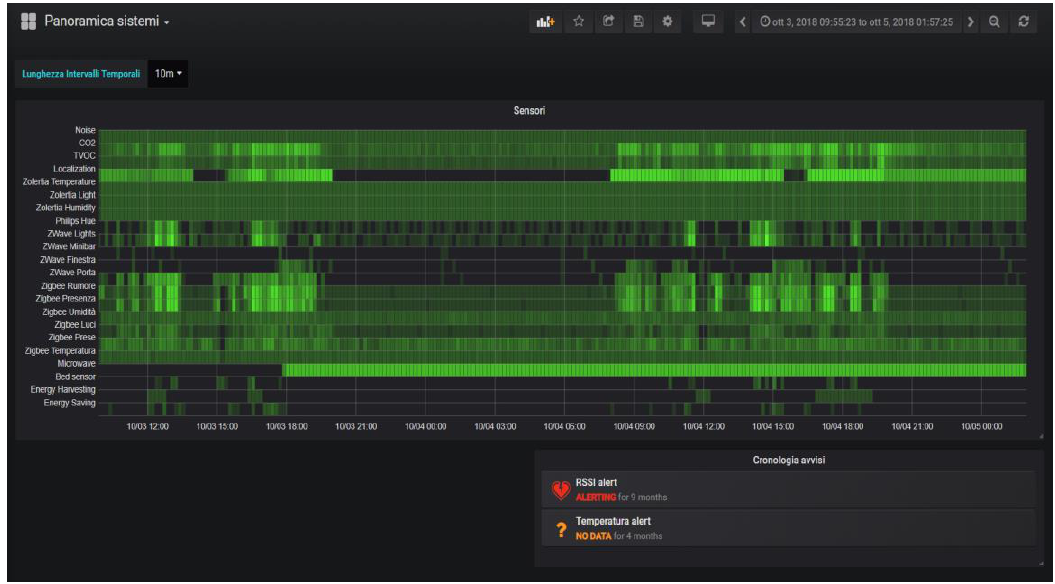
Figure 4. Overall data availability panel.